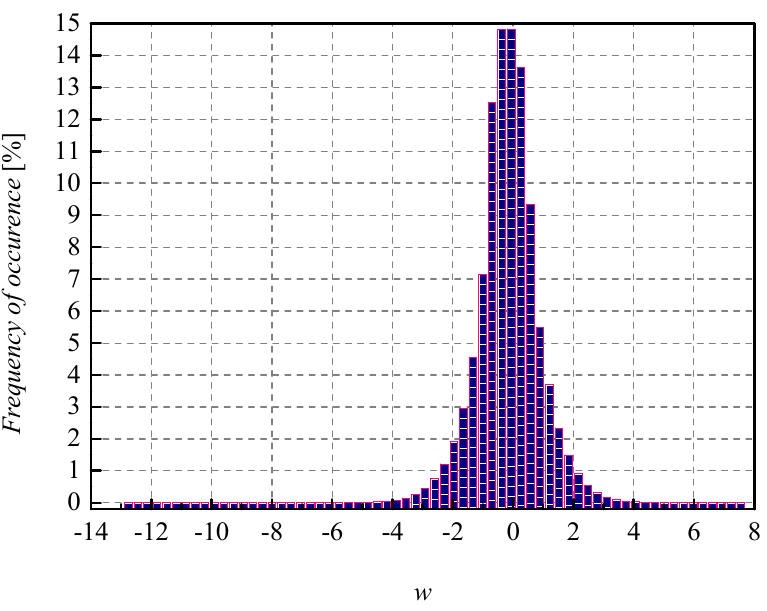
Figure 8. Normalized histogram of weights (FP32) for CNN trained on Fashion-MNIST dataset.